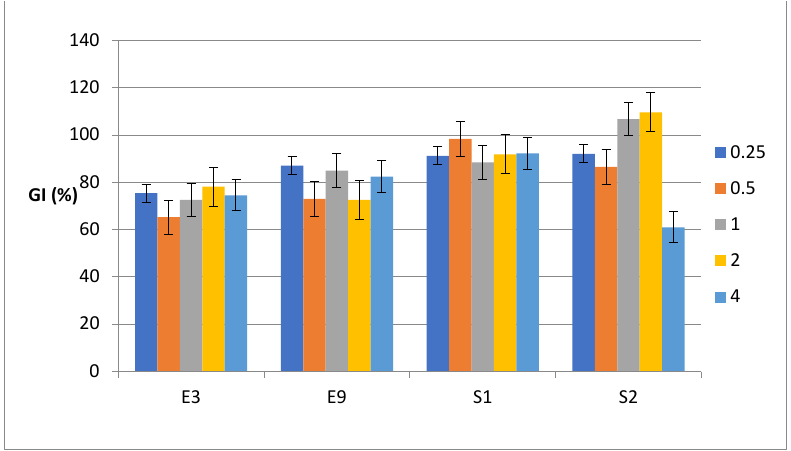
Figure 1. Germination index (%), considering the distilled water as the control (100%) for maize seeds grown in Petri dish, treated with four different biocomponents (plant extract E3, plant extract E9, supernatant S1, supernatant S2) in five concentrations (0.25; 0.5; 1; 2; 4%, w / v ). The bars on the top of the columns represent the SE ( n = 4).